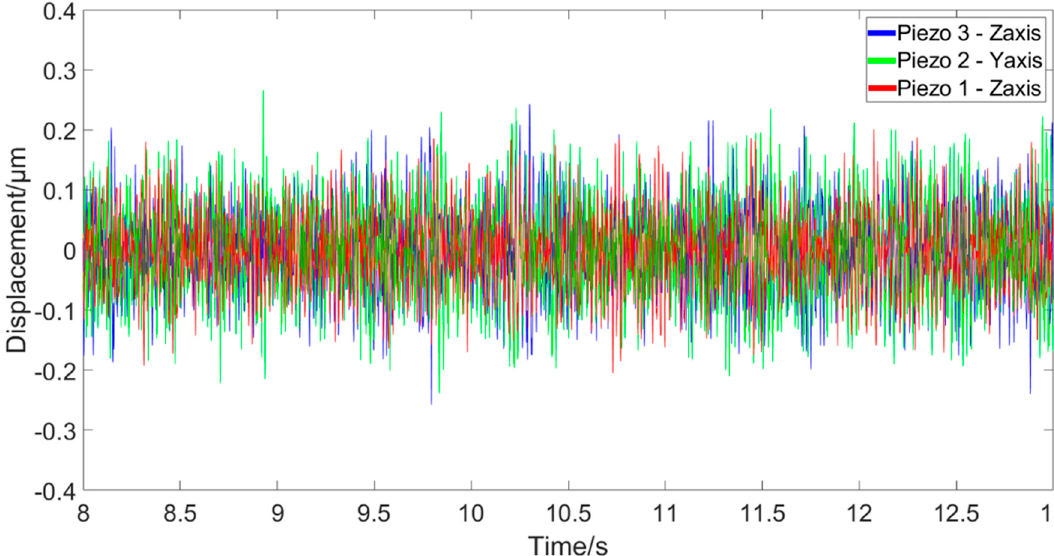
Figure 7. Displacement results for the three channels that have been identified to have the largest average responses in the system within the time window analysed, which was 5 s in the example shown.